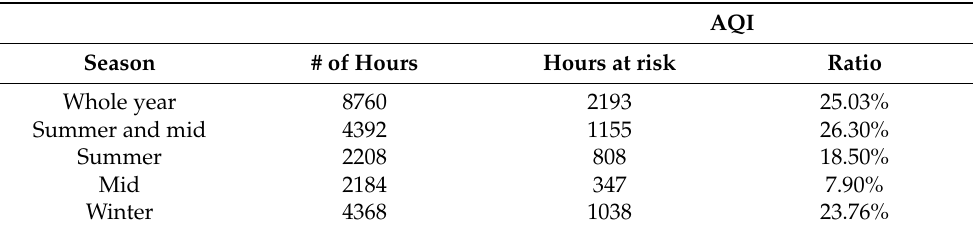
Figure 5. Final degree of air pollution risk in the AQI based on 2019’s values from Milano v. Juvara. Table 4. Summary results of the allocated air pollution distress, when using AQI > 100 as the criterion, differentiated by